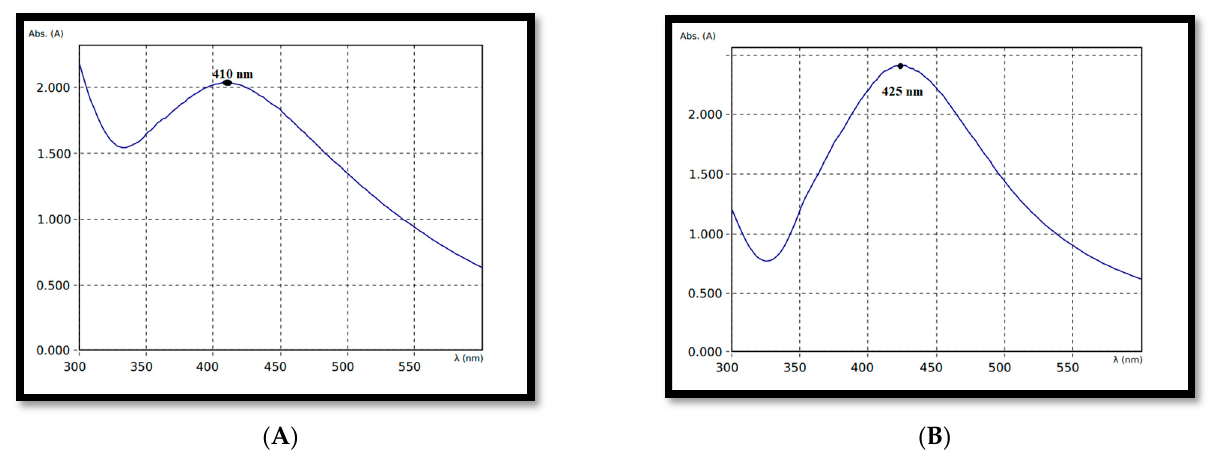
Figure 1. ( A ) Color variation of A. indica -silver nitrate solution after silver nanoparticle formation. ( B ). Color variation of P. pinnata -silver nitrate solution after silver nanoparticle formation.